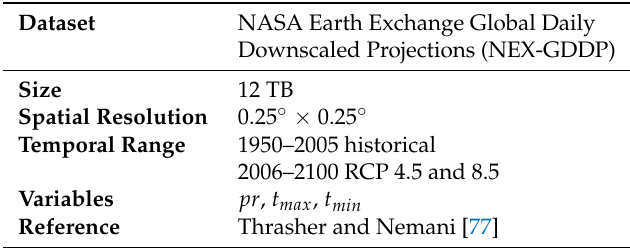
Table 2. Dataset